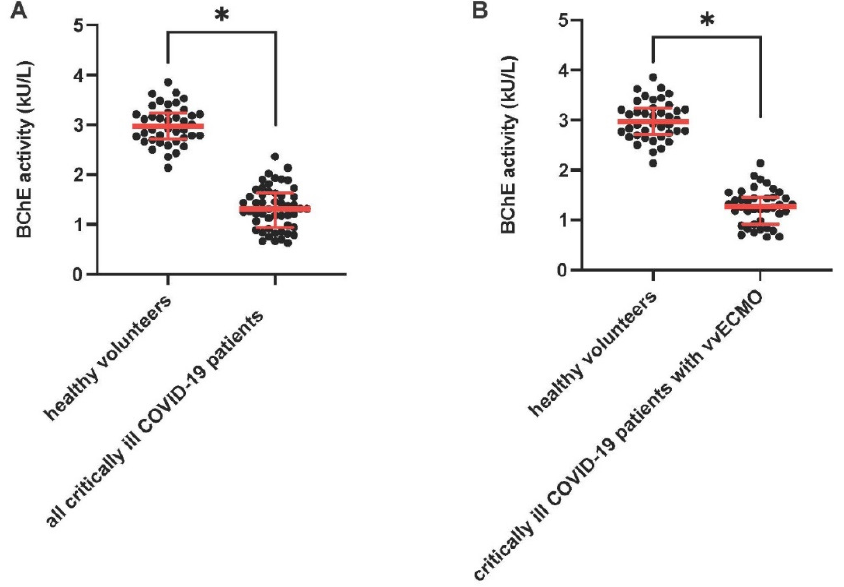
Figure 1. BChE activity in critically ill COVID-19 patients compared to healthy volunteers. Scatterplots represent POCT-based measurements of BChE activity in all critically ill COVID-19 patients (n = 52); ( A ) and in critically ill COVID-19 patients with vvECMO therapy (n = 39); ( B ) compared to previously published healthy volunteers (n = 40) [18] 24 h after ICU admission. * p < 0.05. Mann–Whitney U-Test.